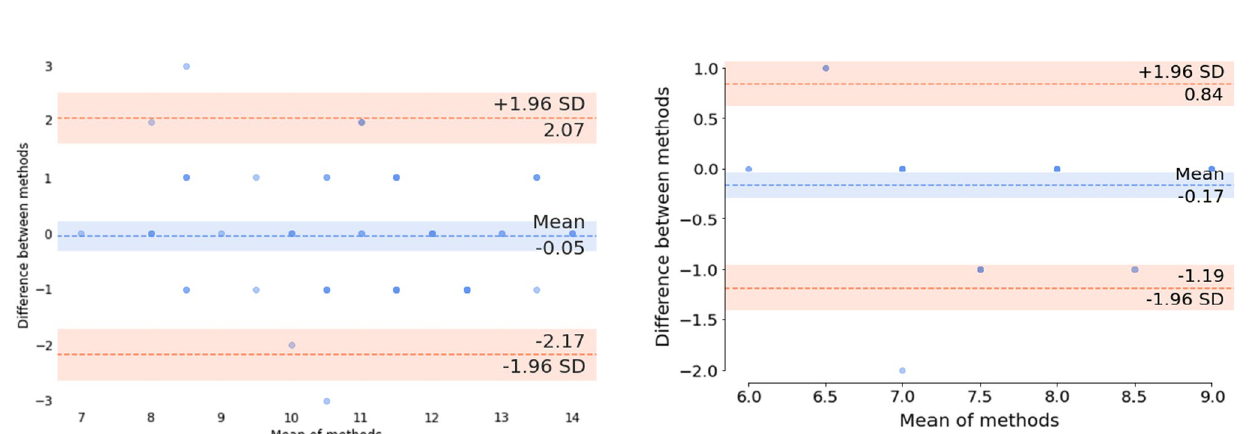
Fig. 7 EC observations